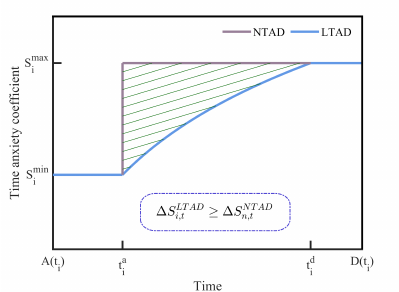
Figure 3. The time anxiety impact of LTAD.